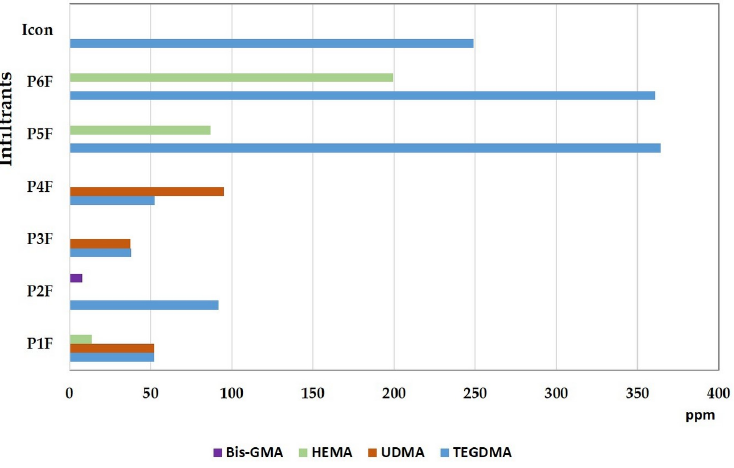
Figure 8. Quantitative values of the residual monomers for experimental infiltrants with filler in their composition, compared to Icon.